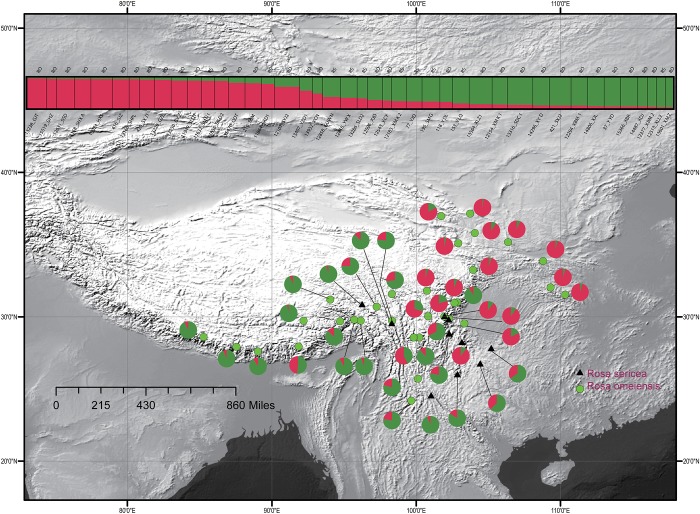
Geographic distribution of the 42 populations of the R. sericea complex color-coded according their groups inferred with analysis in STRUCTURE of eight nuclear microsatellite (nSSR) loci. Histogram of the STRUCTURE assignment test for 42 populations (507 individuals) shown at top. Population codes and abbreviation for species are identified in Table 1. Map generated in ESRI ArcGIS 10.0 (Esri, 2010).